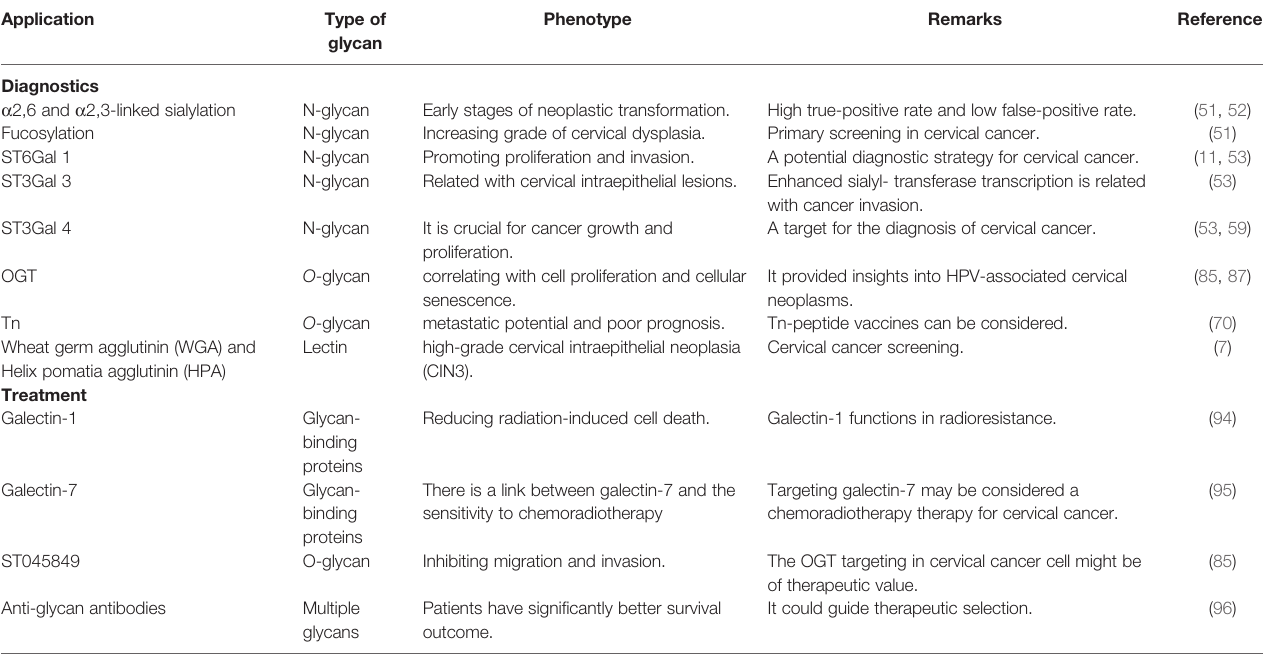
TABLE 1 | Key application of glycan-based biomarkers in cervical